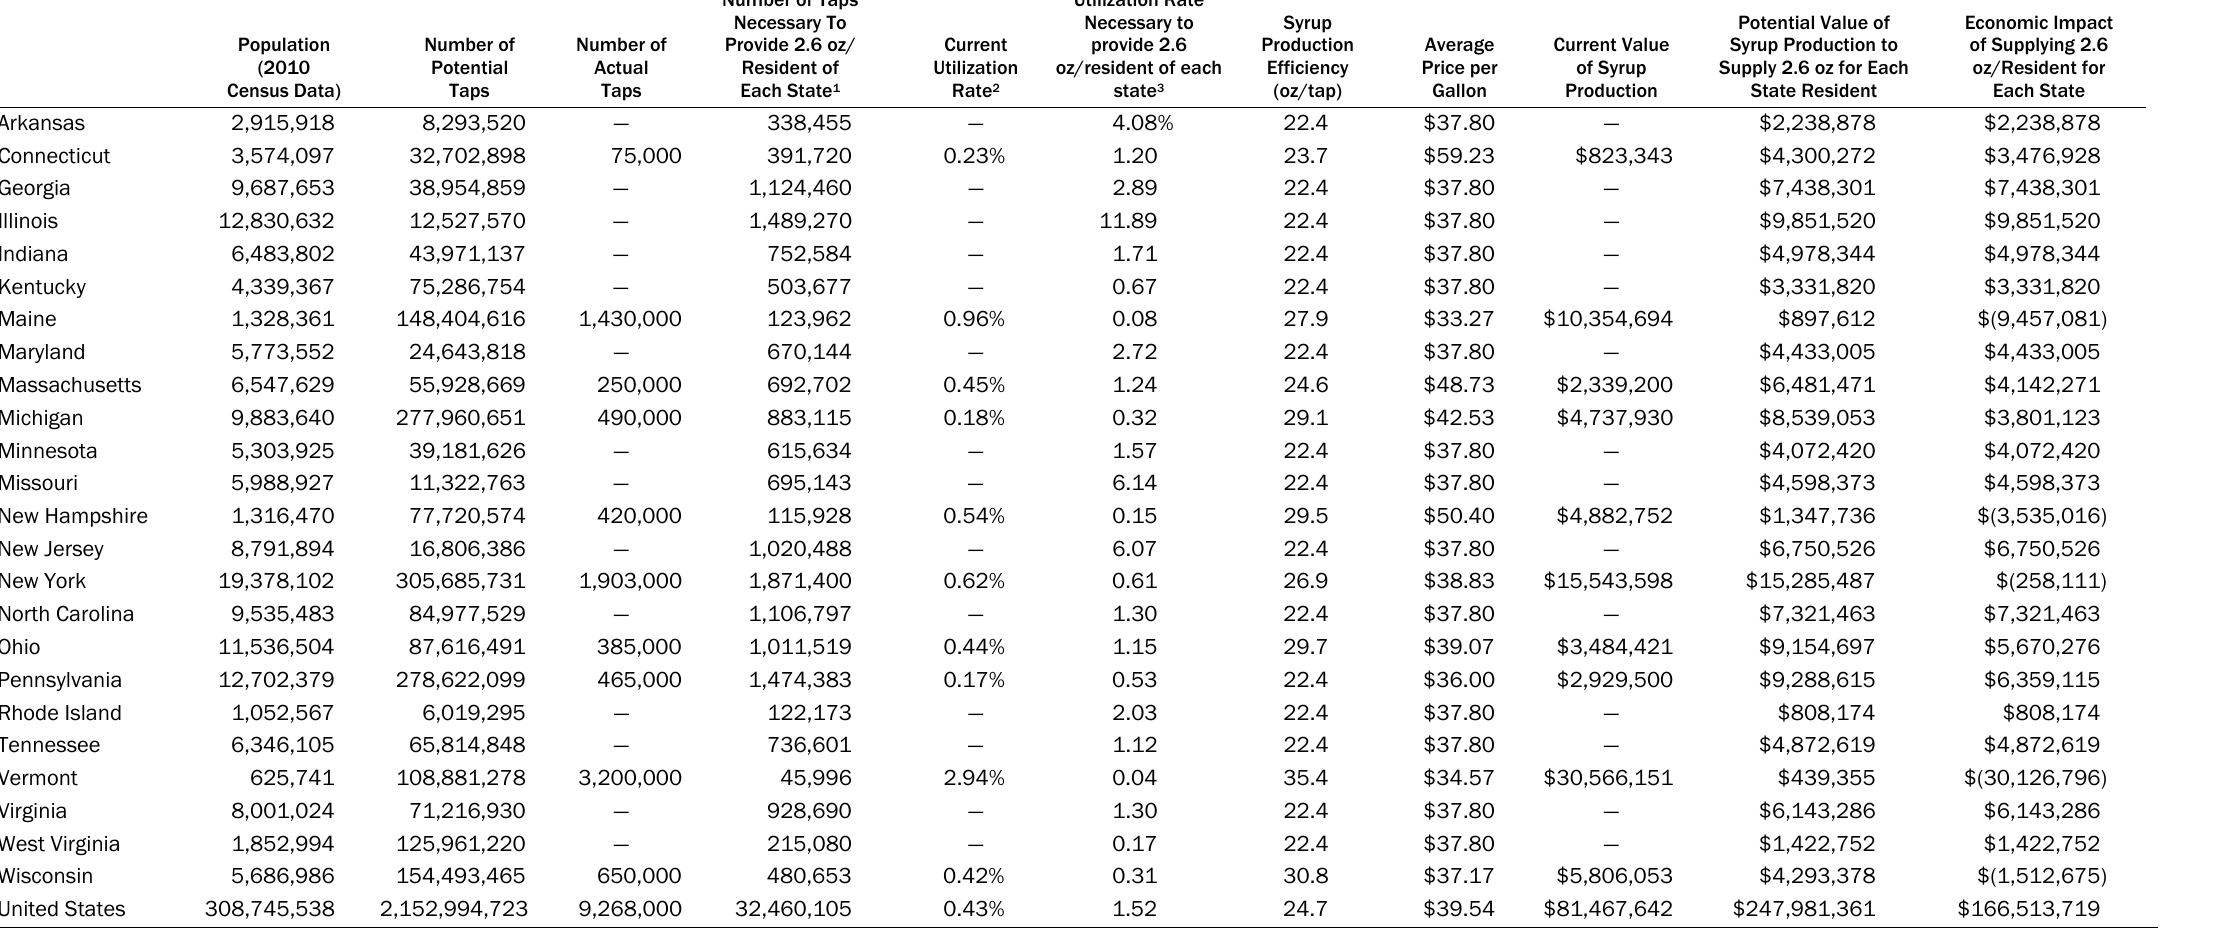
Table 2. Economic Impact of Producing All of the Maple Syrup Consumed in a State Locally (all prices in